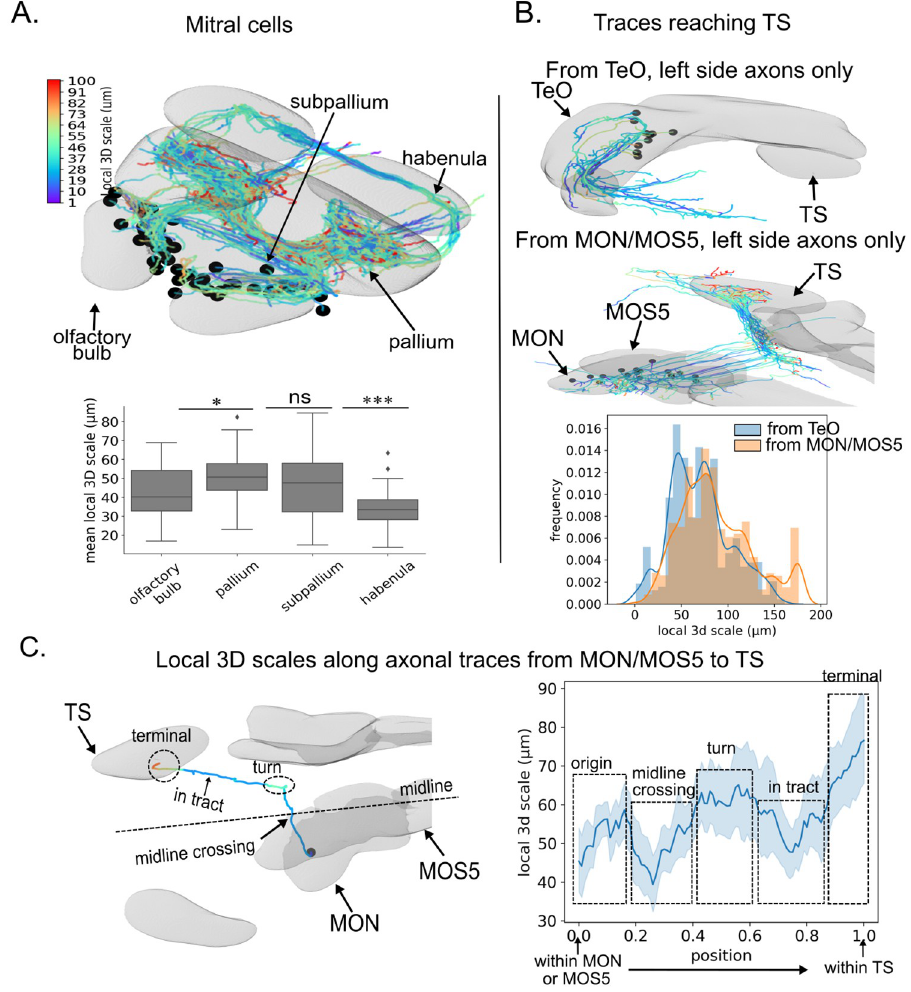
Fig 4. Local 3D scale along different axonal populations. (A) Local 3D scale variation along axons of mitral cells. (B) nAdder analysis of TS-terminating axons originating from the Optic Tectum (TeO) (top) and Medial Octavolateral Nucleus (MON) or Medulla Oblongata Strip 5 (MOS5) (middle). Comparison of the distributions of local 3D scale of axons coming from the two regions (bottom). (C) Local 3D scale variations along axons coming from MON/MOS5. Left, example view of one axon indicating different segments of interest. Right, quantification (n = 32 axons). The maximum scale in A is set to 100 μ m based on the width of the largest brain region analyzed. The maximum scale in B is set to 175 μ m based on the mean length of the longest branch. Only the longest branches are included in the computation. Wilcoxon tests with Holm-Sidak corrections for multiple comparison were used, � p � 0.05, �� p � 0.01, ��� p � 0.005, ���� p �